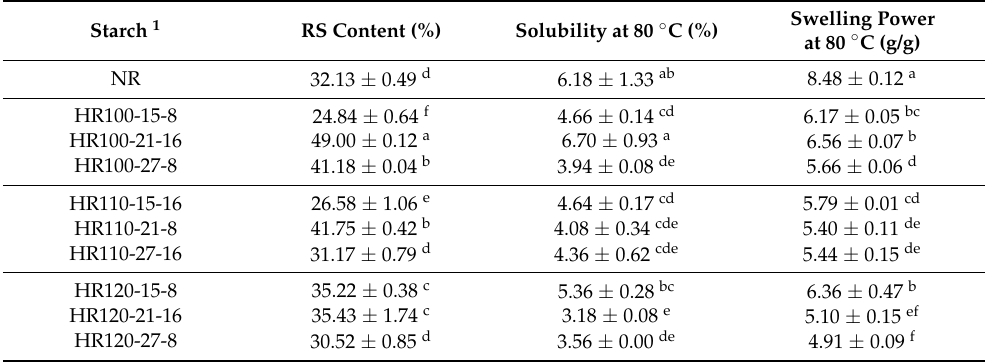
Table 1. RS content, solubilities and swelling powers of heat–moisture treated rice starch under different treatment